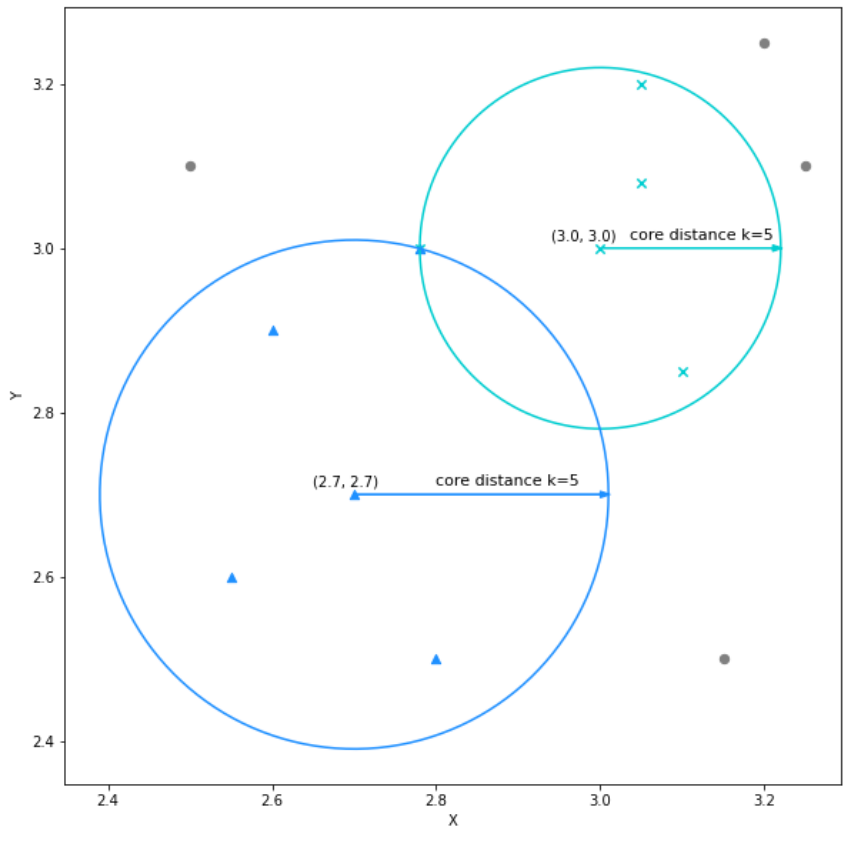
Figure 2. The core distances for the points ( 2.7,2.7 ) and ( 3.0,3.0 ) for k = 5, using a zoomed in view on a particular area of the simple